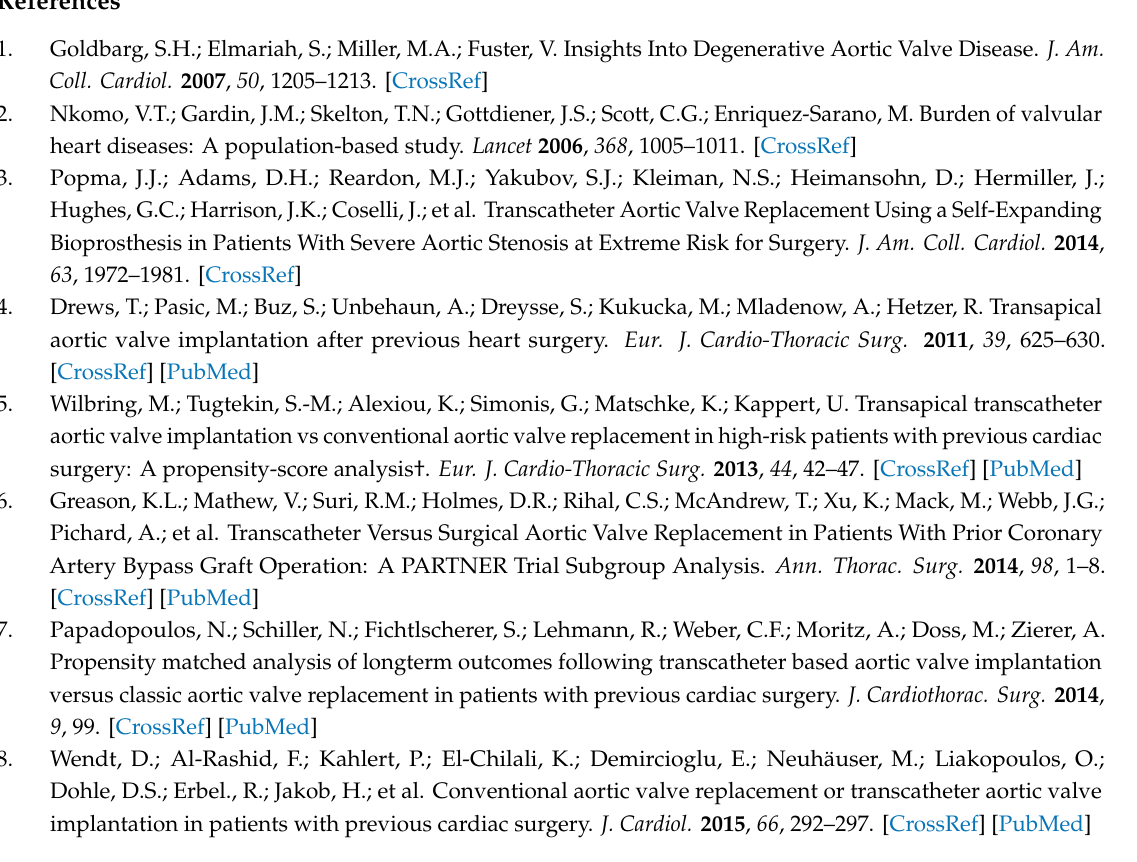
Figure S1: Forest plot comparing the risk of acute kidney injury between transcatheter versus surgical aortic valve replacement; Figure S2: Forest plot comparing the procedural time between transcatheter versus surgical aortic valve